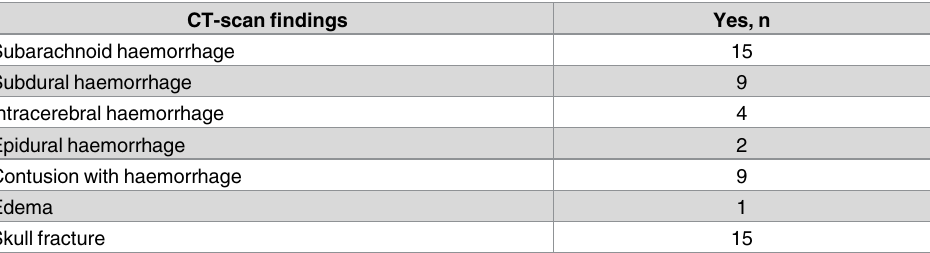
Table 2. CT-scan findings detected in CT-positive mTBI patients.